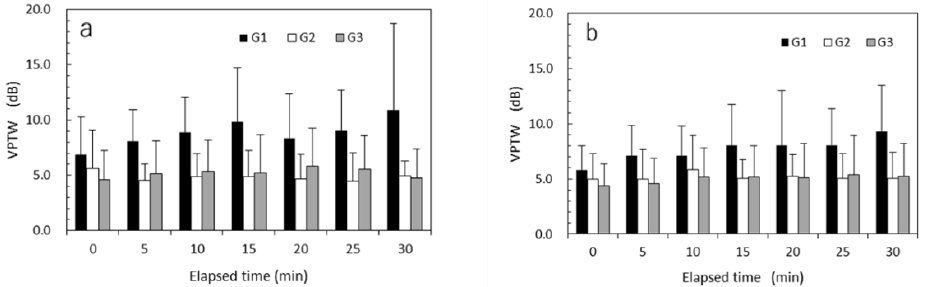
Figure 7. Vibrotactile perception threshold width (VPTW) at a VPT test frequency of 125 Hz after